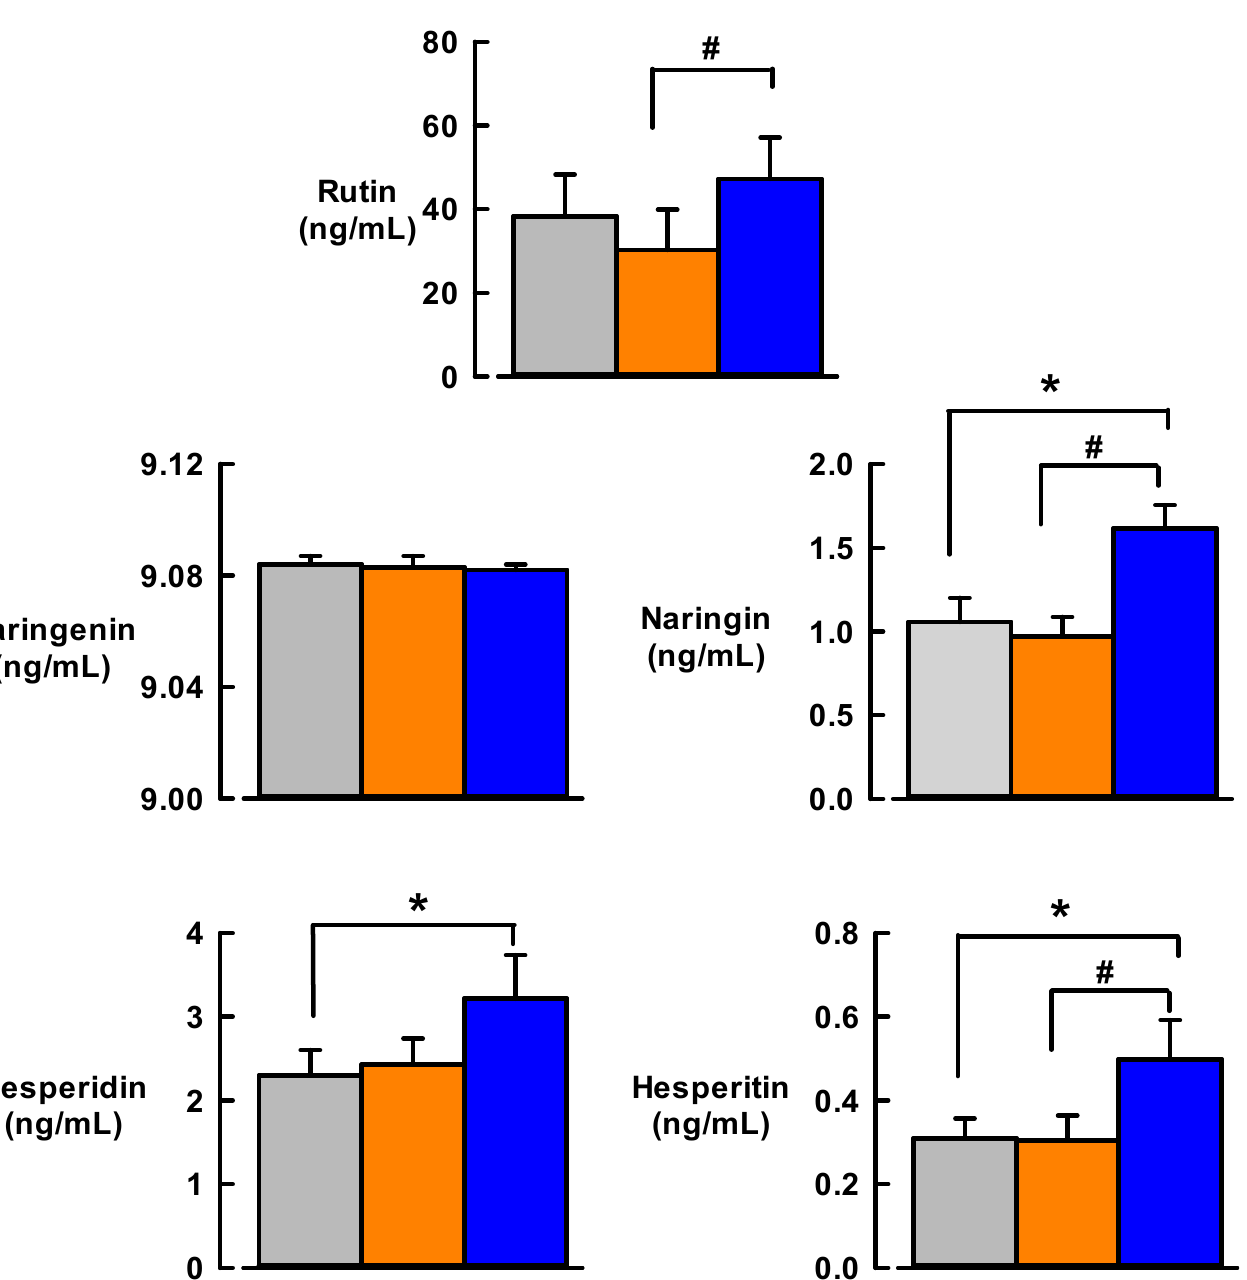
Figure 1. Effect of 12-weeks Mediterranean diet intervention (blue bars) or usual diet (orange bars) on citrus bioflavonoid levels compared with baseline levels (grey bars) in participants with Type 2 diabetes. Sample size: N = 18 for naringenin, naringin, hesperidin, hesperitin; N = 9 for rutin. Data are mean ±SEM. * p < 0.05, different from baseline; # p < 0.05, different from usual diet. Table 3. Predicted correlations between changes in the plasma levels of DPP-4, BGL and HBA1c and changes in plasma levels of citrus bioflavonoids following MedDiet intervention.